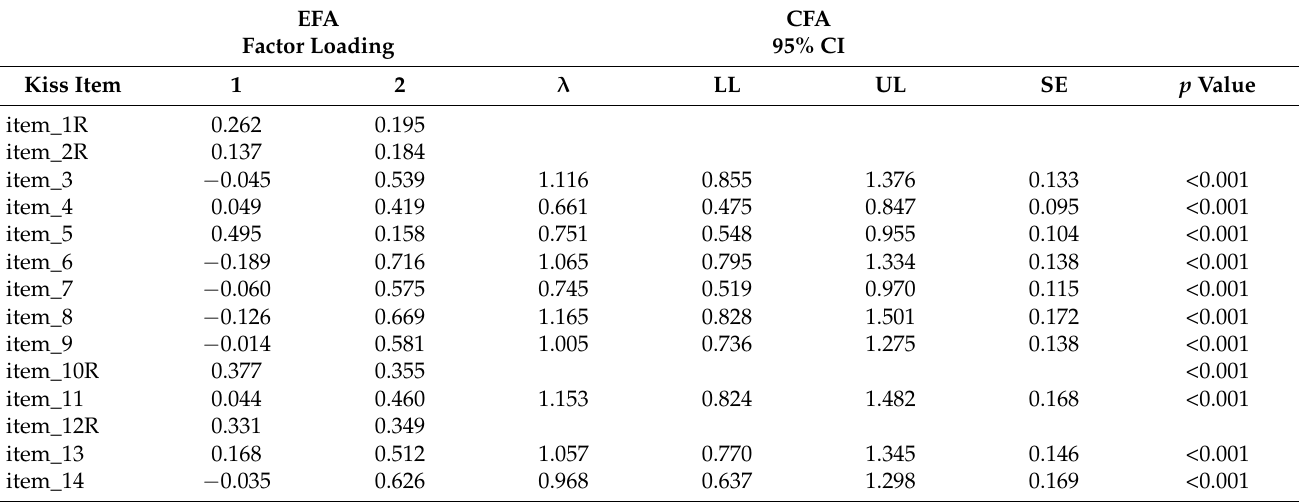
Table 2. EFA and CFA Factor